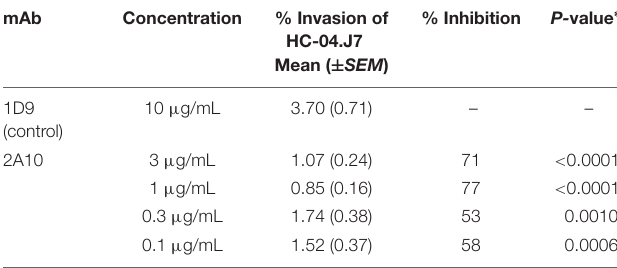
TABLE 1 | Inhibition of liver stage development assay.